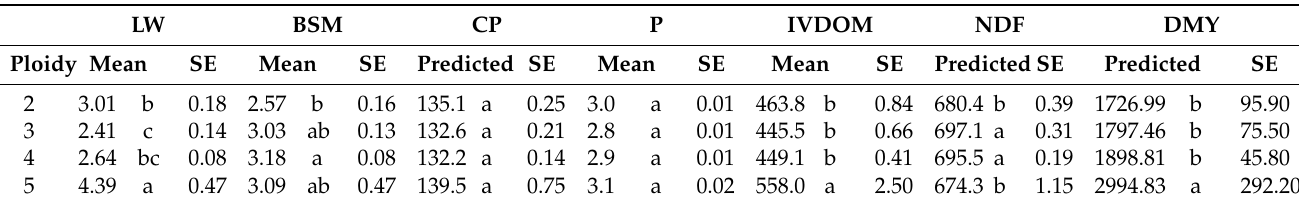
Table 2. Mean values and standard error (SE) of each ploidy level for leaf width (LW, cm), Bermudagrass Stem Maggot (BSM) tolerance (1 = 10 percent or less damage, 9 = 90 percent or more damage), nutritive value traits (g kg − 1 ): crude protein (CP), phosphorus (P), in vitro digestible organic matter (IVDOM), neutral detergent fiber (NDF), and dry matter yield (kg ha − 1 ) (DMY) based on predicted values of all the USDA forage bermudagrass germplasm accessions for each trait. LW BSM CP